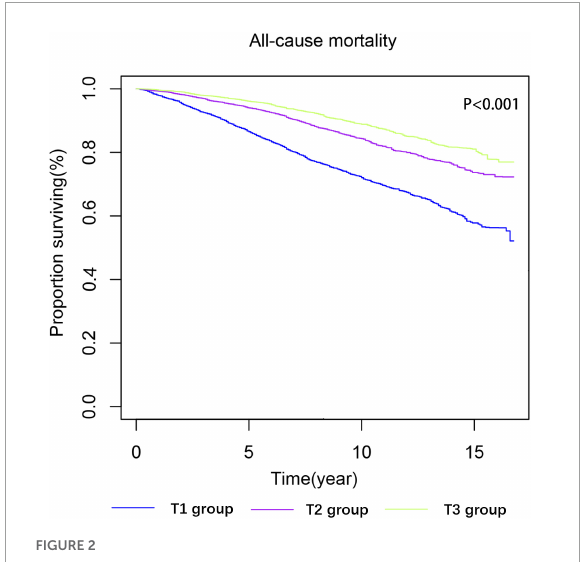
FIGURE2 Kaplan-Meier survival estimates for long-term all-cause mortality (weighted).